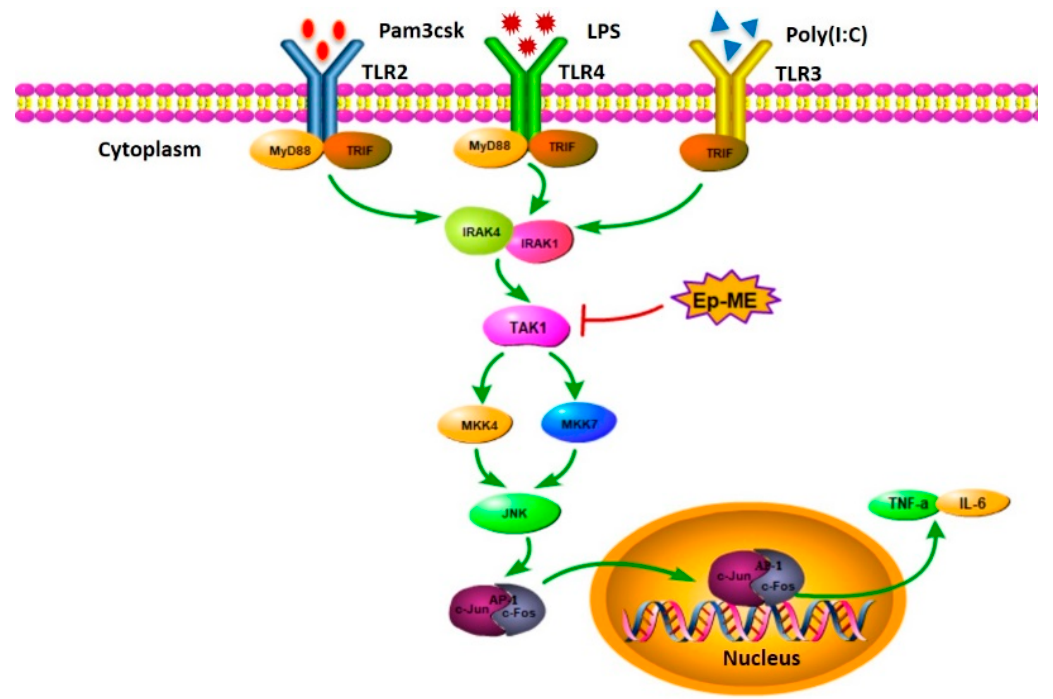
Figure 5. Schematic diagram of the anti-inflammatory activity of Ep-ME when targeting TAK1 in the AP-1 signaling pathway.